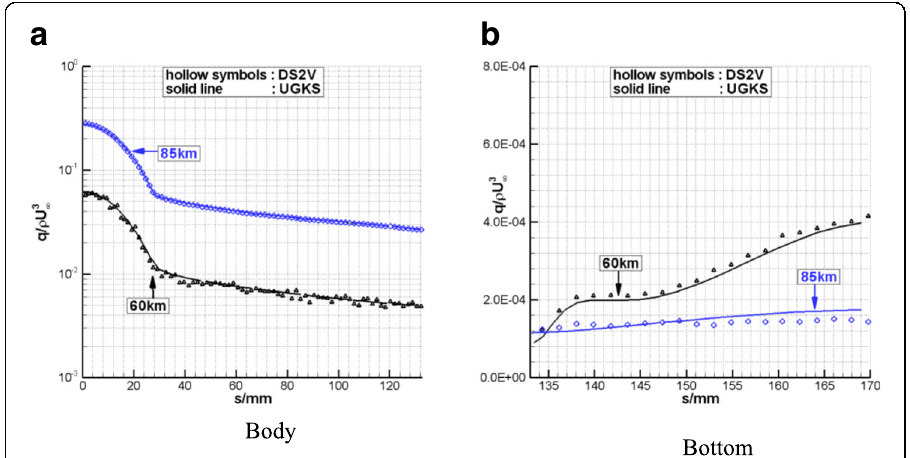
Fig. 25 Heat flux distributions on the cone surface ( a ) Body ( b ) Bottom